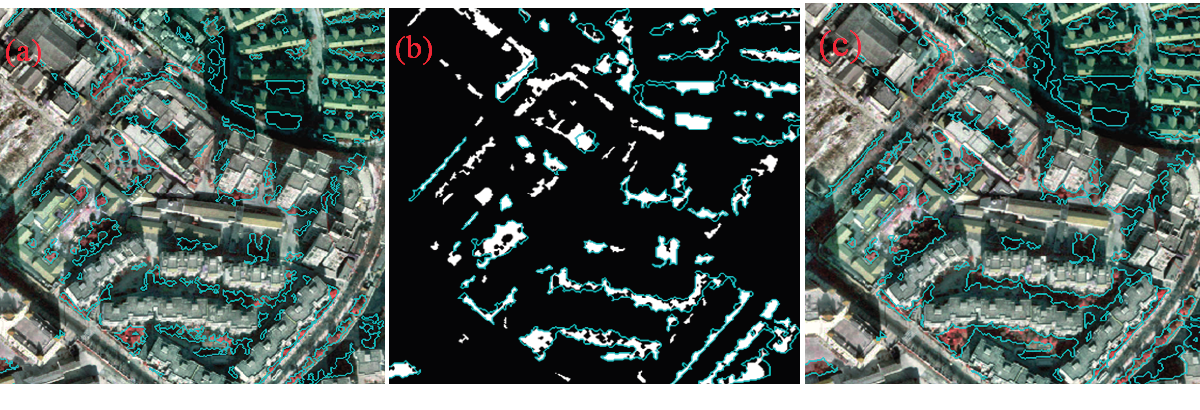
Figure 8. An example of repairing vegetation objects by the renewed stable